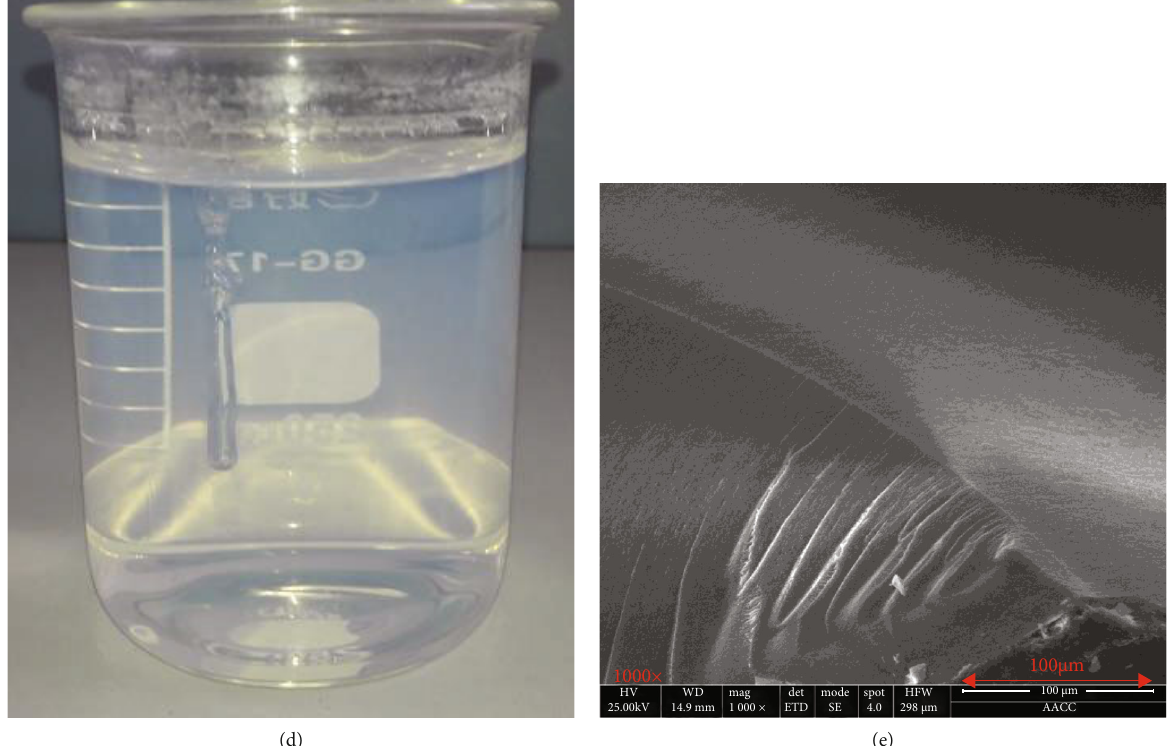
Figure 2: Double-electron layer structure and gel process of silica sol. (a) Double-electron layer structure of silica sol; (b) photo of silica sol and NaCl solution; (c) viscosity versus time curves for grout with di ff erent proportions; (d) gel reaction products; (e) scanning electron microscope photo of gel reaction